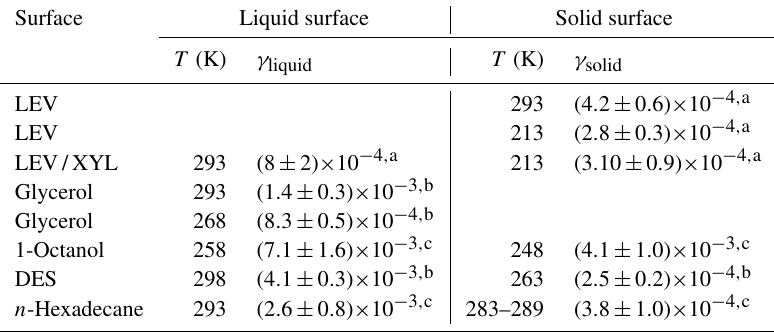
Figure 8. Reactive uptake coefficients, γ , of NO 3 reacting with (a) levoglucosan (LEV) and (b) 1 : 1 by mass LEV and xylitol (XYL) mixture as a function of temperature. The dashed line represents the glass transition temperature ( T g ) measured in the poke-flow experiment. Table 2. Comparison of uptake coefficients of NO 3 on liquid and solid substrates of saturated and unsaturated organics.